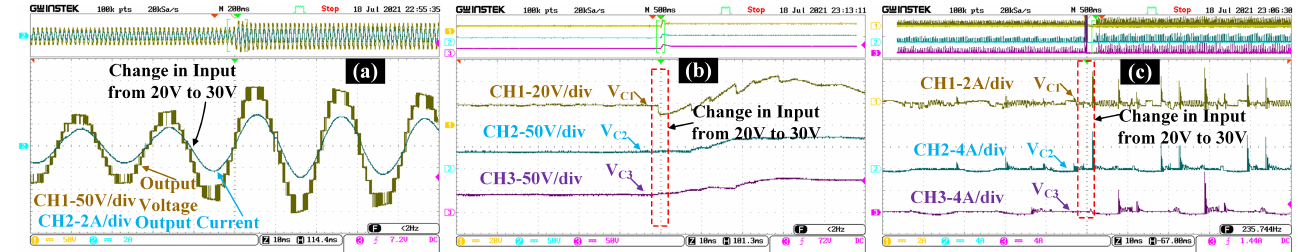
Figure 8. Experimental Results for load 50 Ω , 20 mH when V in changes from 20 V to 30 V. ( a ) Output voltage and Output current, ( b ) Voltage across capacitor ( V C 1 , V C 2 , V C 3 ), ( c ) Capacitor current profile ( I C 1 , I C 2 , I C 3